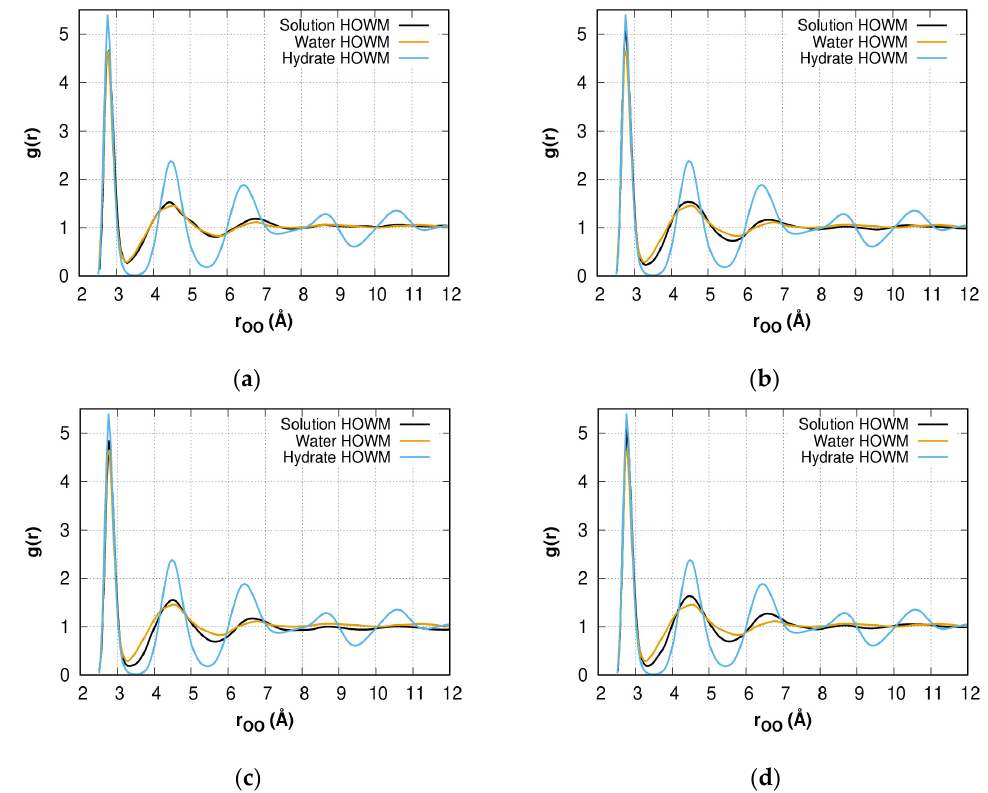
Figure 4. The highly ordered water molecule (HOWM) oxygen–oxygen (eigen F 3 < 0.025) RDF g(r) for the 0.6 methane solution, pure water, and bulk phase methane hydrate at different simulation time points: ( a ) t = 0.1 ns; ( b ) t = 4.0 ns; ( c ) t = 6.0 ns; ( d ) t = 10.0 ns. Water and hydrate data are averaged over the simulation time. The r OO distance distribution step is 0.01 Å.